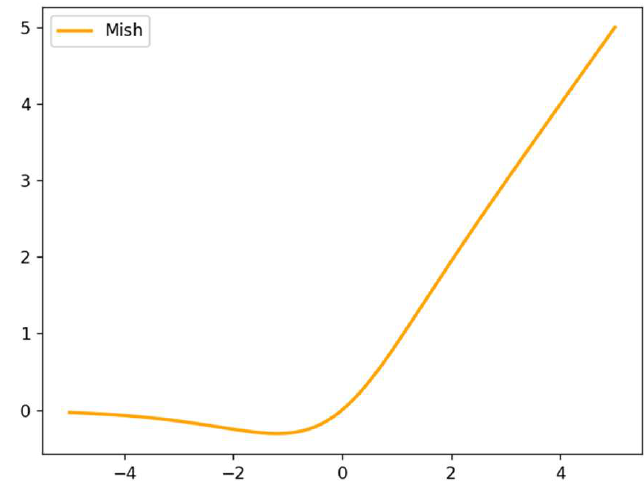
Figure 13. Mish activation function.